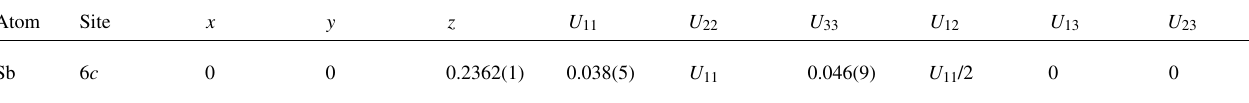
Table 2. Atomic coordinates and displacement parameters (in Å 2 ) .